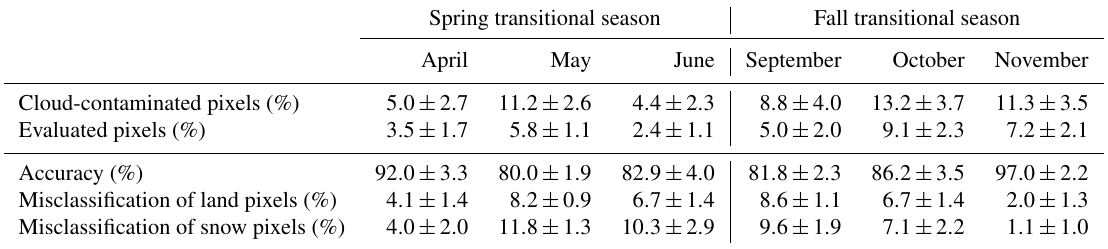
Table 2. The accuracy of the spatial filter algorithm applied to the Aqua MODIS SCE data during spring (April to June) and fall (September to November) transitions averaged over Alaska from 2003 to 2015. Pixels that identified cloud contamination in the Aqua MODIS record but indicated clear conditions in the Terra MODIS were used for evaluation. The percentage of cloud-contaminated and evaluated pixels were calculated for the entire Alaska domain, while the accuracy and misclassification were calculated as the percentage of the evaluated pixels. Both Terra and Aqua MODIS SCE data show similar accuracy, while only the Aqua MODIS results are shown here due to a higher percentage of cloud-contaminated pixels (available for evaluation) in the Aqua